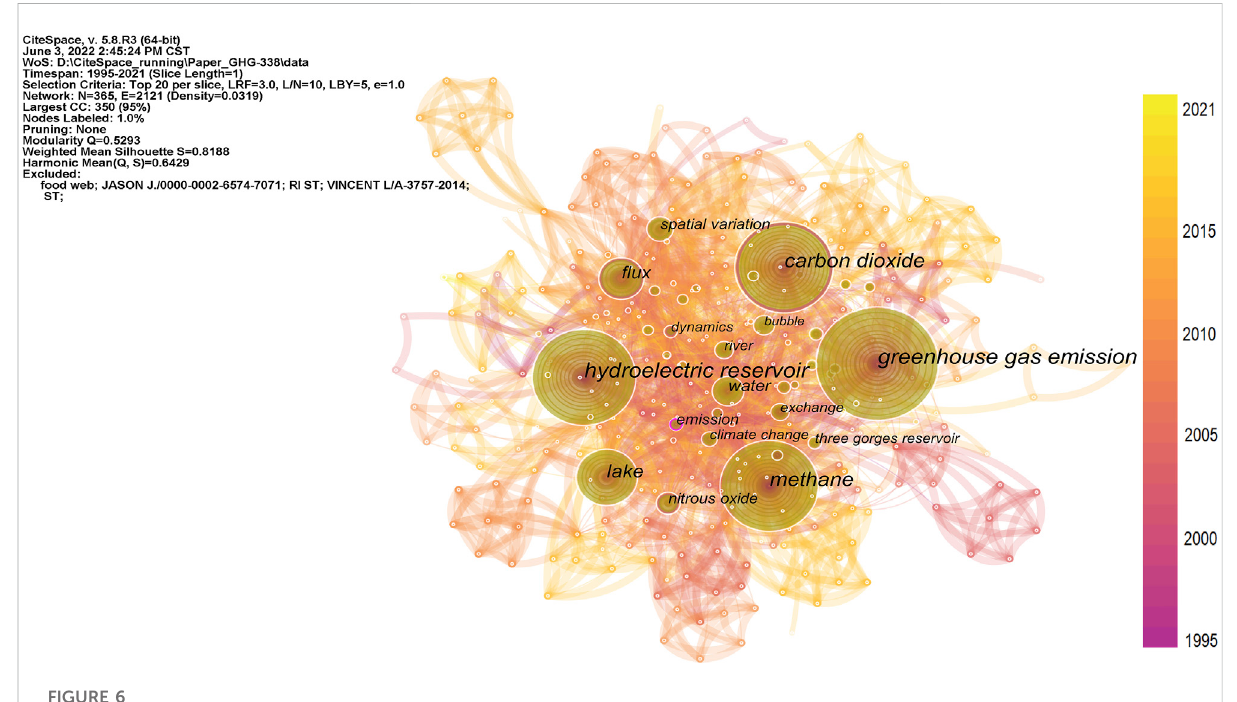
FIGURE 6 Keyword co-occurrence network in GHG-HR research fi eld.